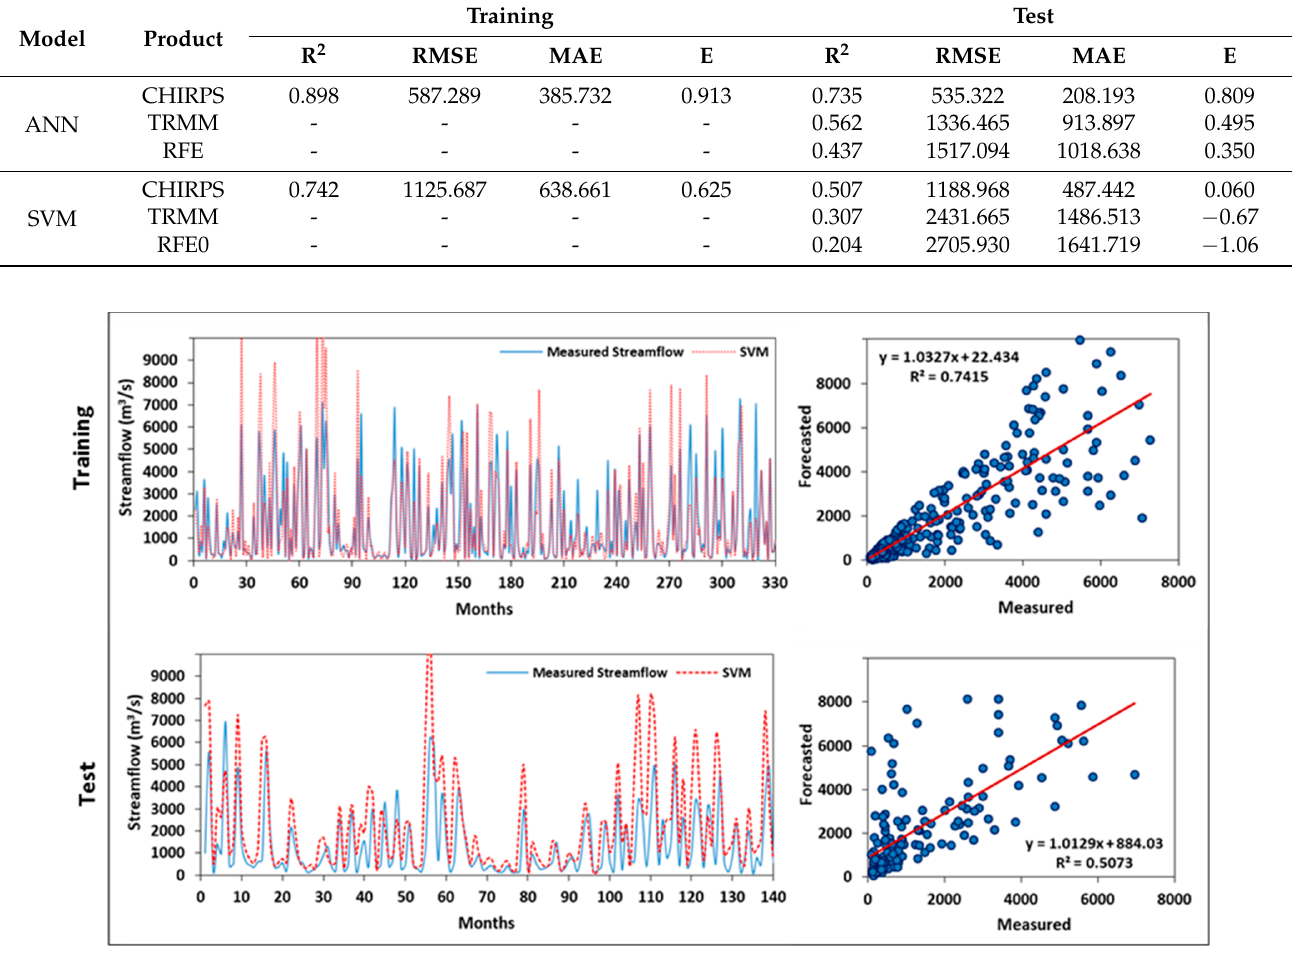
Figure 8. SVM training and test results of the simulated monthly streamflow at El Diem station based on the CHIRPS dataset.